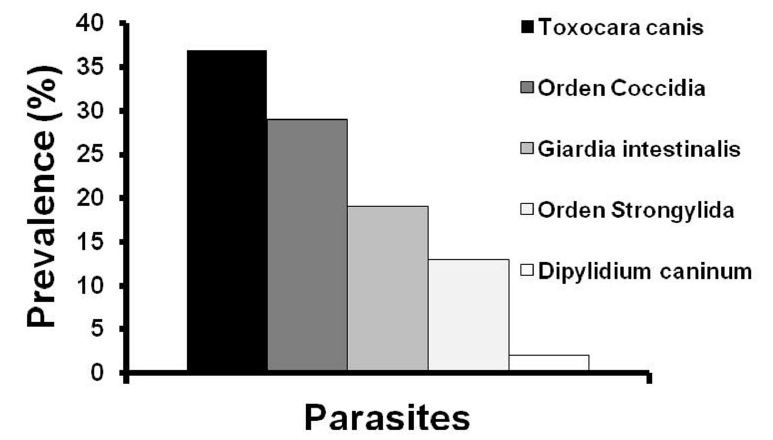
Figure 1. Prevalence of gastrointestinal parasites in owned dogs from urban